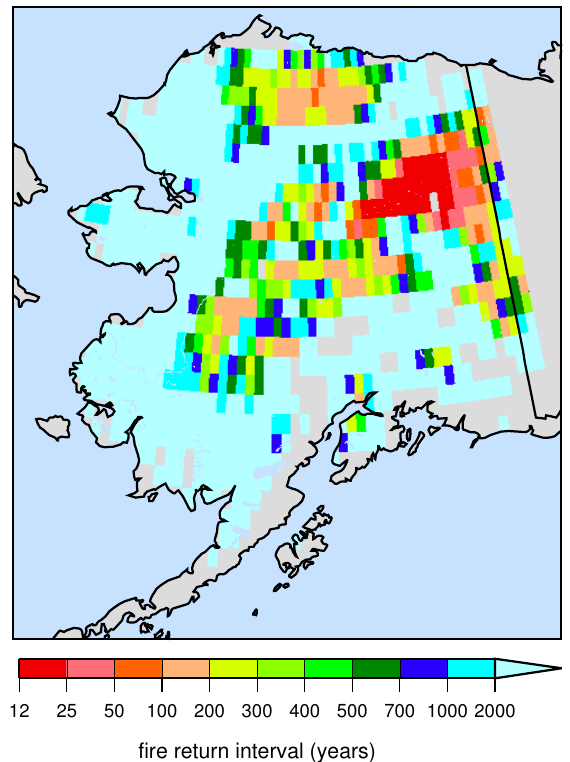
Fig. 9. Simulated fire return intervals in Alaska for a 1000yr run with detrended 20th century climate. To facilitate comparison, the colour schemes used here and in Fig. 11 are the same as those used in Balshi et al.